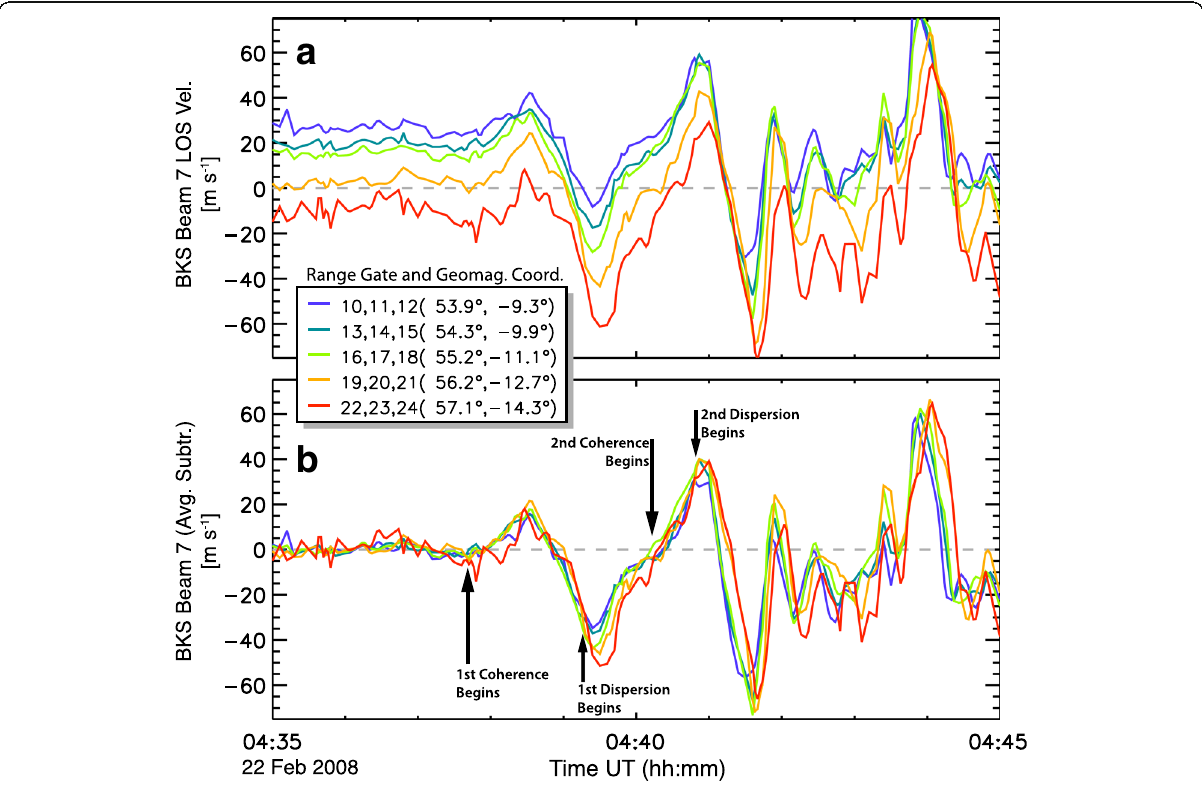
Fig. 33 a The BKS LOS velocity as a function of latitude and time. The BKS data along beam 7 are averaged over three range gates and plotted as a function of UT for five sets of gates covering the latitude range of 53.9° N to 57.1° N. b The difference between the first part of each of the first two cycles and the second part. Reproduced from Fig. 3 of Frissell et al.